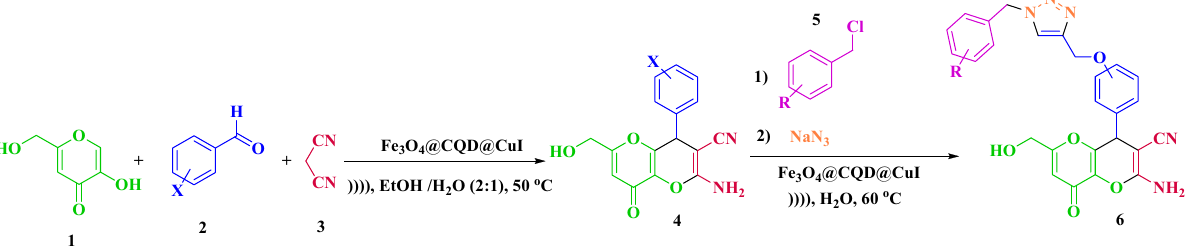
Figure 1. Synthesis of kojic acid based dihydropyrano-pyran and kojic acid-triazole based dihydropyrano- pyran in click reaction by Fe 3 O 4 @CQD@CuI as catalyst in the optimized